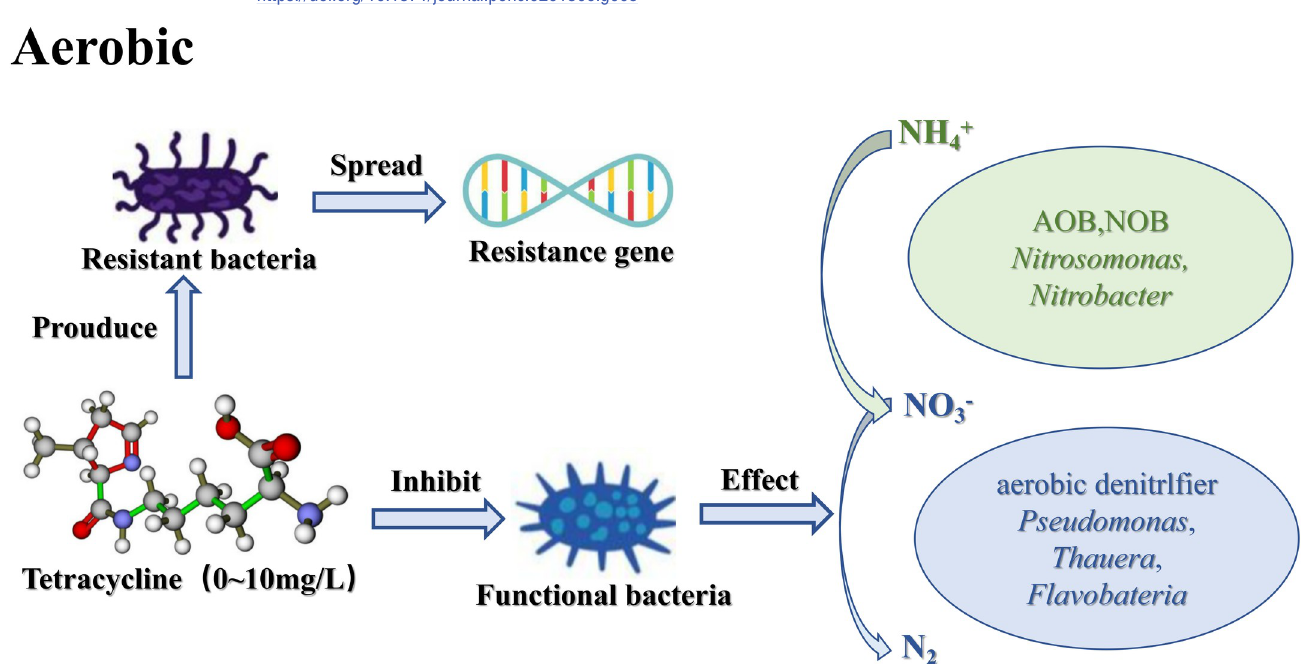
Fig 6. Mechanism diagram of nitrogen removal under TC stress. https://doi.org/10.1371/journal.pone.0261306.g006 PLOS ONE | https://doi.org/10.1371/journal.pone.0261306 January 10,